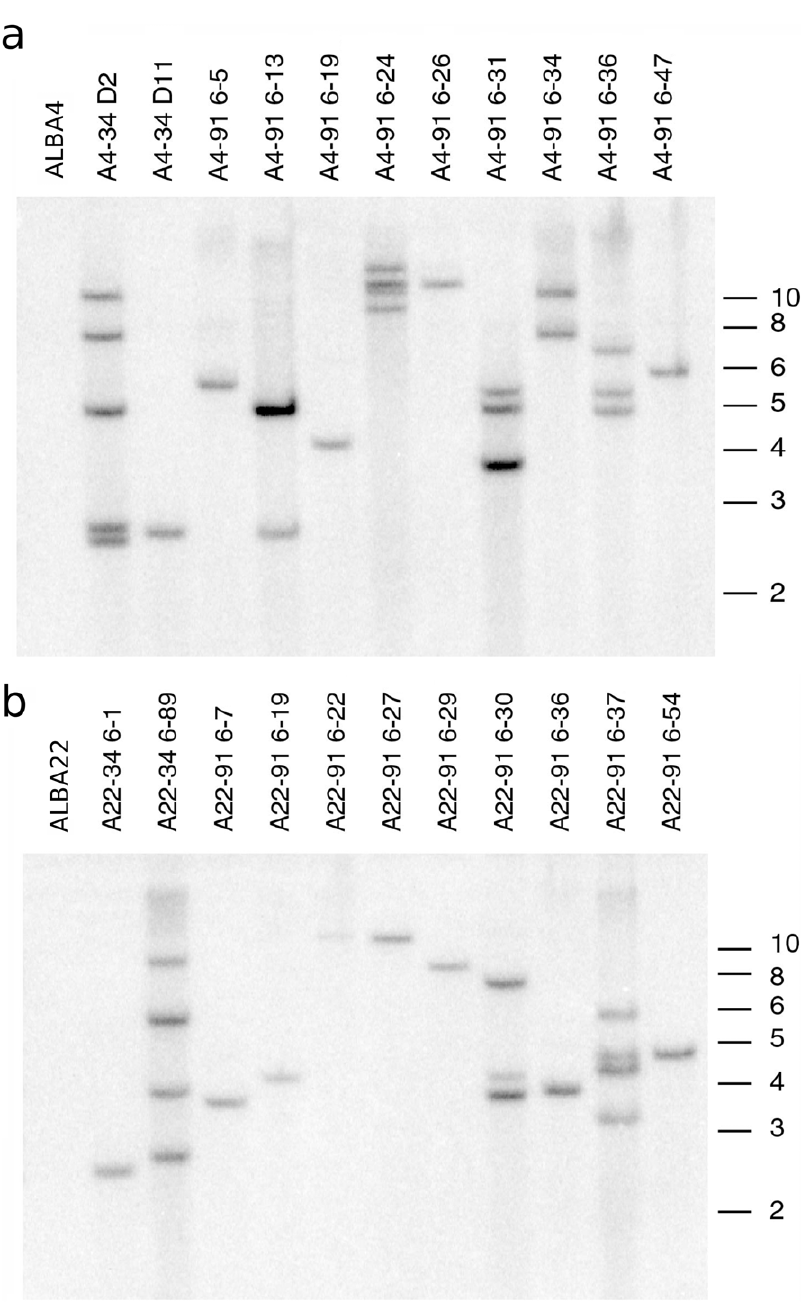
Figure 3. Stable integration and estimated copy number of switchgrass CAD silenced lines. Autoradiogram of DNA blot hybridized with a radiolabelled probe from within the hpt coding region ( a ) Untransformed (far left) and pWBVec8-transformed (second and third from left) lines as well as pEC129-transformed individuals derived from ALBA4. ( b ) Same as in (a) but individuals are derived from ALBA22. Untransformed (far left) and pWBVec8-transformed individuals (second and third from left). Size in kilobases are indicated to the right of each